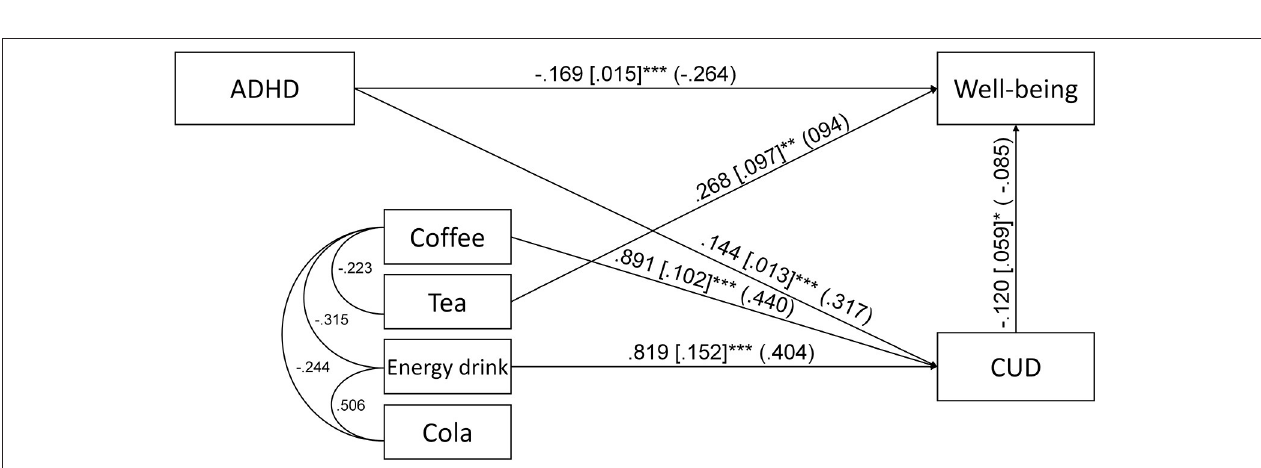
FIGURE 2 | Path analysis for the association of ADHD symptoms, caffeine consumption, caffeine use disorder symptoms (CUD) and well-being ( N = 2,196). Unstandardized regression coefficients, their standard errors (in brackets) and standardized coefficients (in parentheses) are presented in the figure. Only the significant ( p < 0.05) direct paths are presented *** p < 0.001.